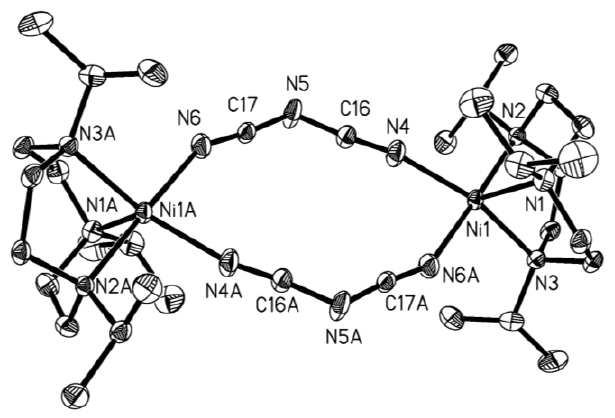
Figure 4. Perspective view of the binuclear NiII complex [LNi(N(CN) 2 )] 2 (BPh 4 ) 2 2 with the atom-numbering scheme.